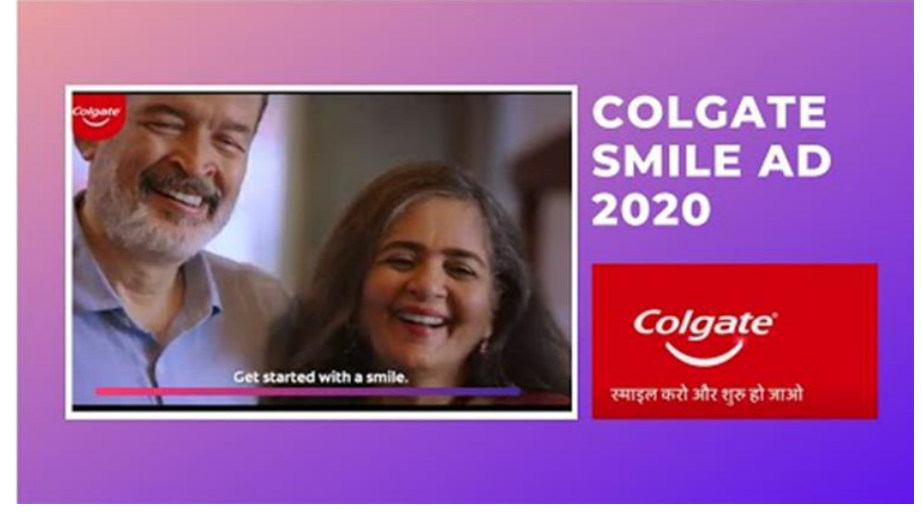
Figure 1: Colgate (India)